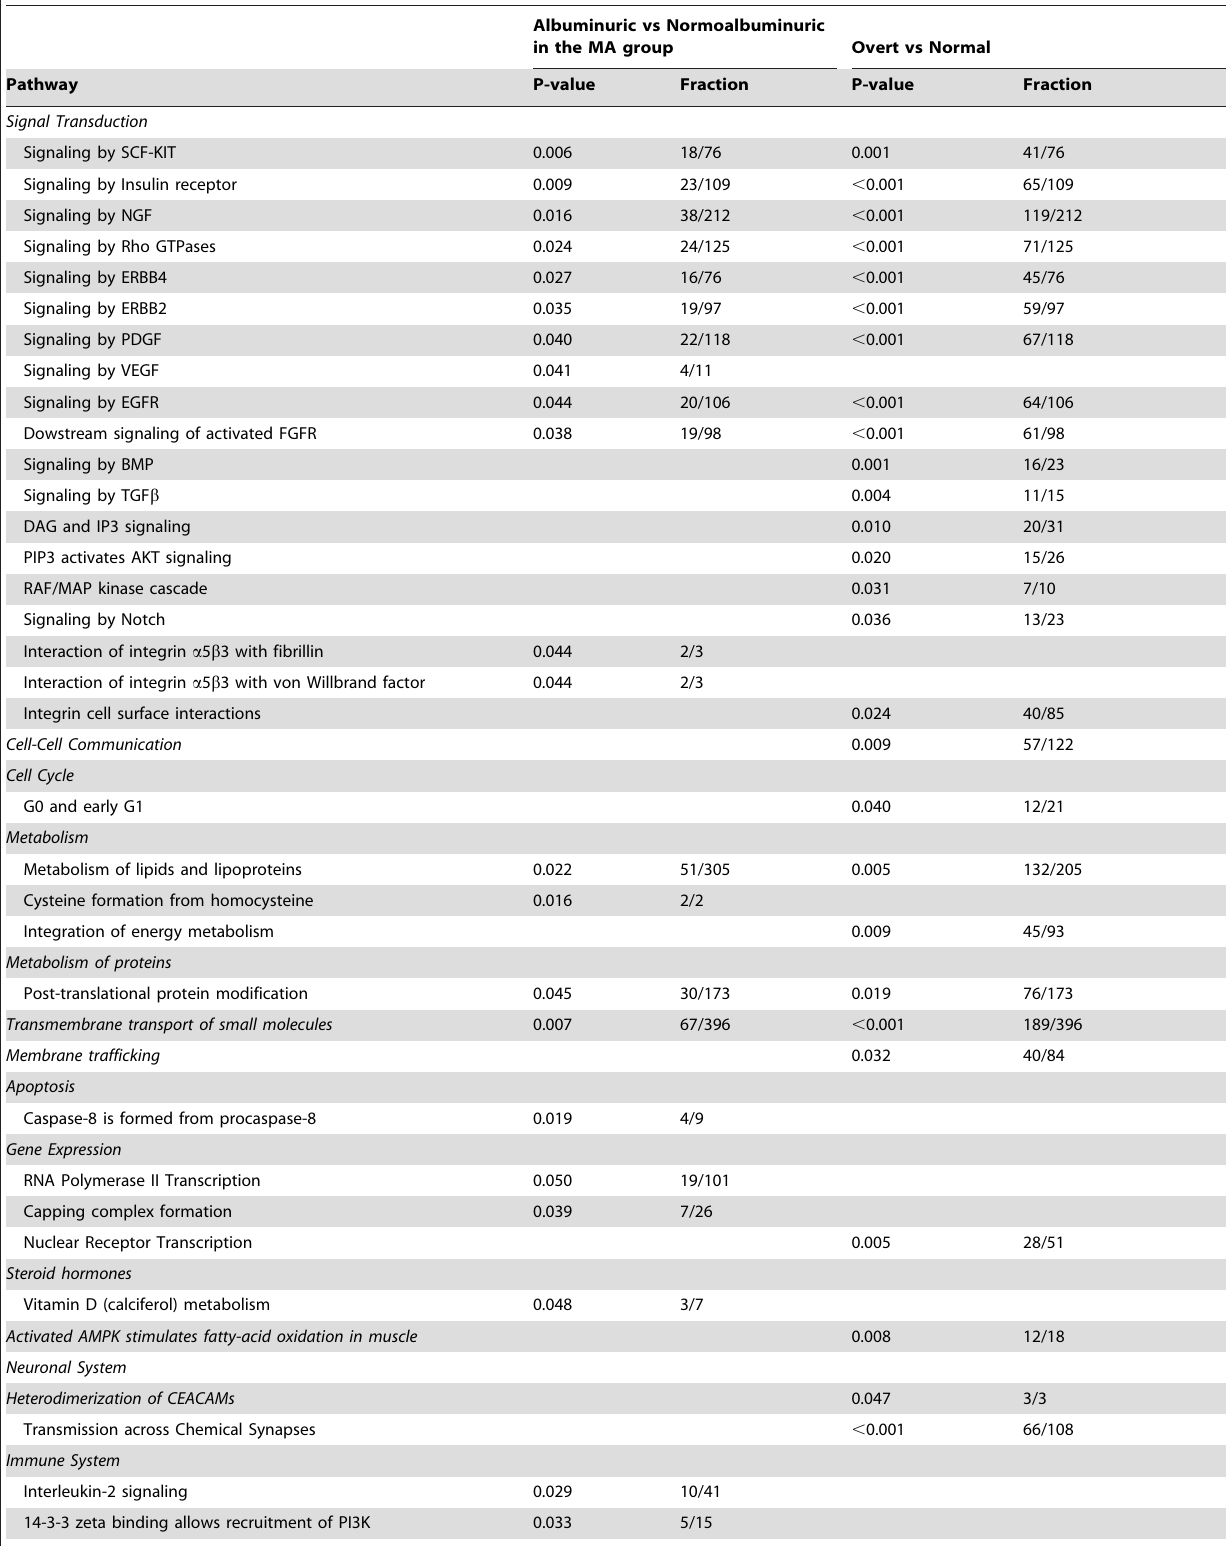
Table 5. REACTOME pathway terms enriched in targets of differentially expressed